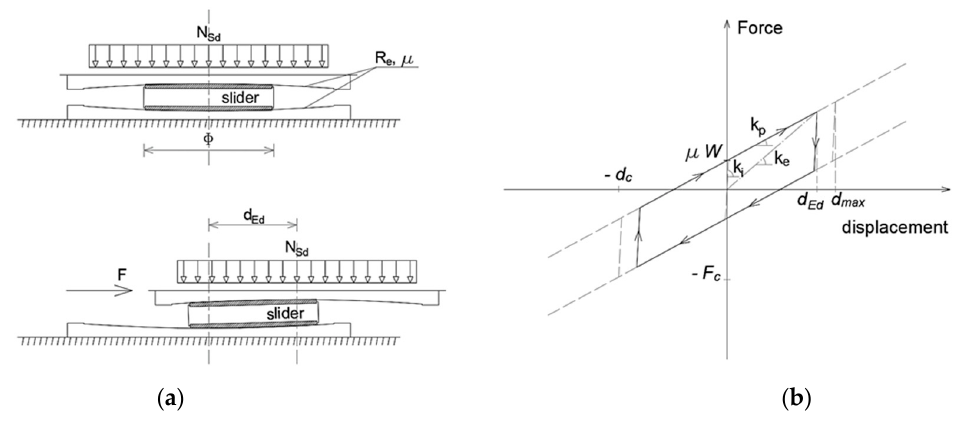
Figure 4. ( a ) DCCSS bearing and ( b ) linear equivalent model.